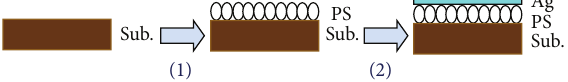
Figure 8: Schematic illustration of silver nanoparticle array fabrica- tion with the following two steps: (1) drop-coating of monolayered PS nanospheres on substrate; (2) deposition of a layer of silver film over the as-coated monolayered PS